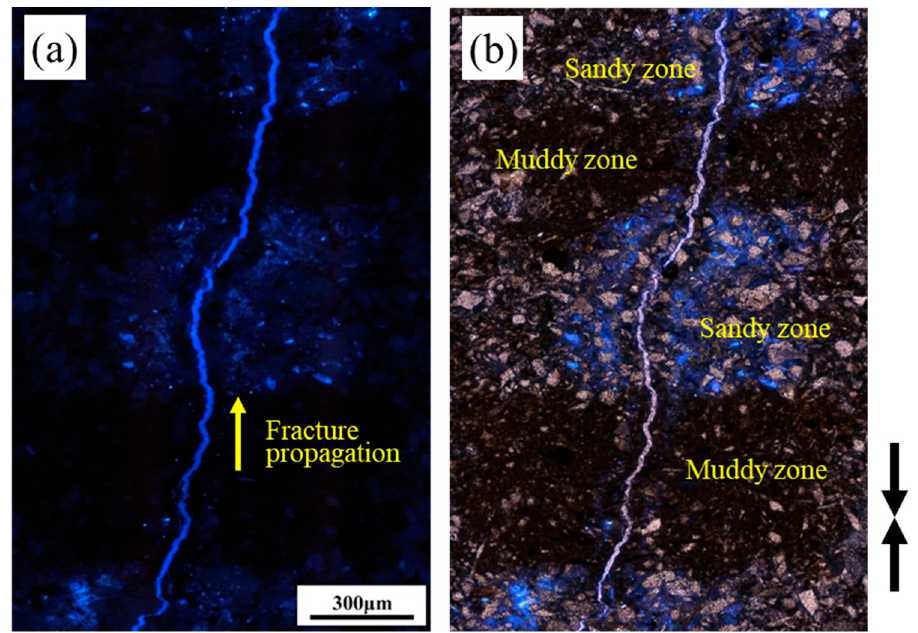
Figure 11. Resin-impregnated regions around the induced fractures observed ( a ) under UV light; ( b ) under a single nicol with UV light. The pair of black arrows next to ( b ) represents the loading direction. The regions are wider in sandy zones than in muddy zones.